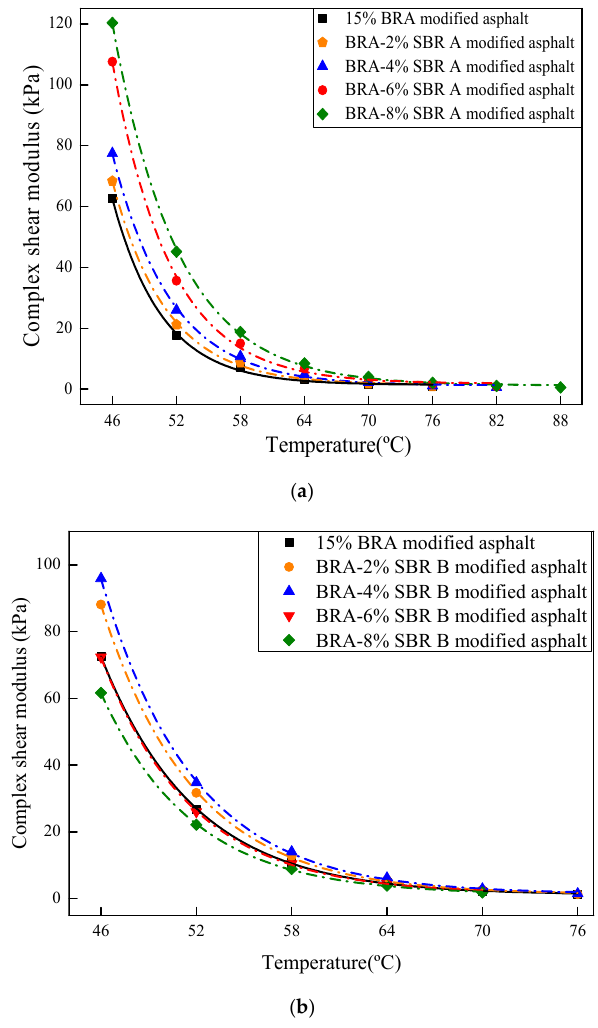
Figure 4. Complex shear modulus of specimens. ( a ) BRA and BRA-SBR A modified asphalt; ( b ) BRA and BRA-SBR B modified asphalt.